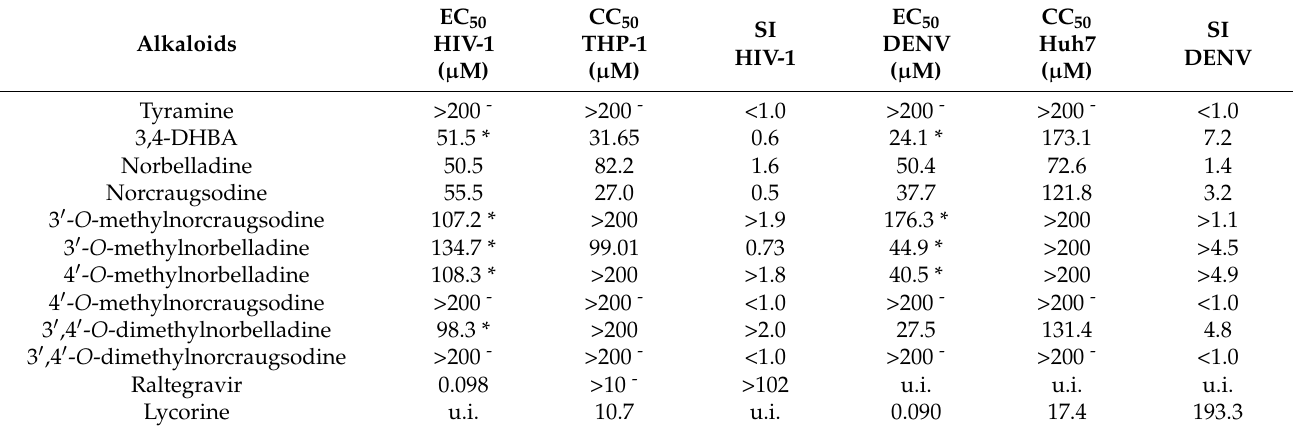
did not yield complete viral inhibition. “u.i.”: unidentified.